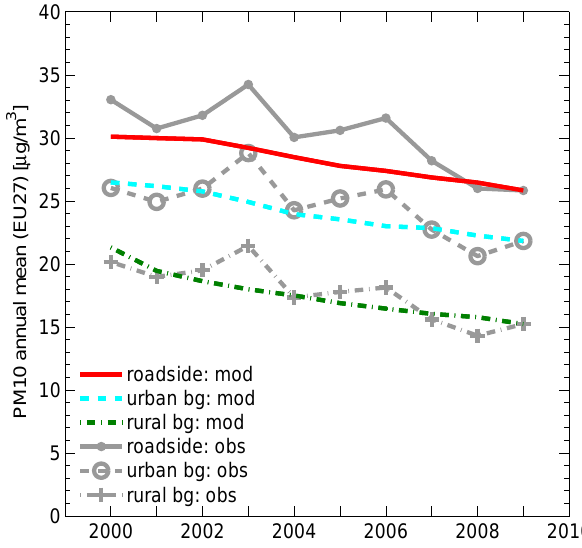
Figure 6. Time series of modelled and observed PM 10 averaged across different categories of monitoring stations in the